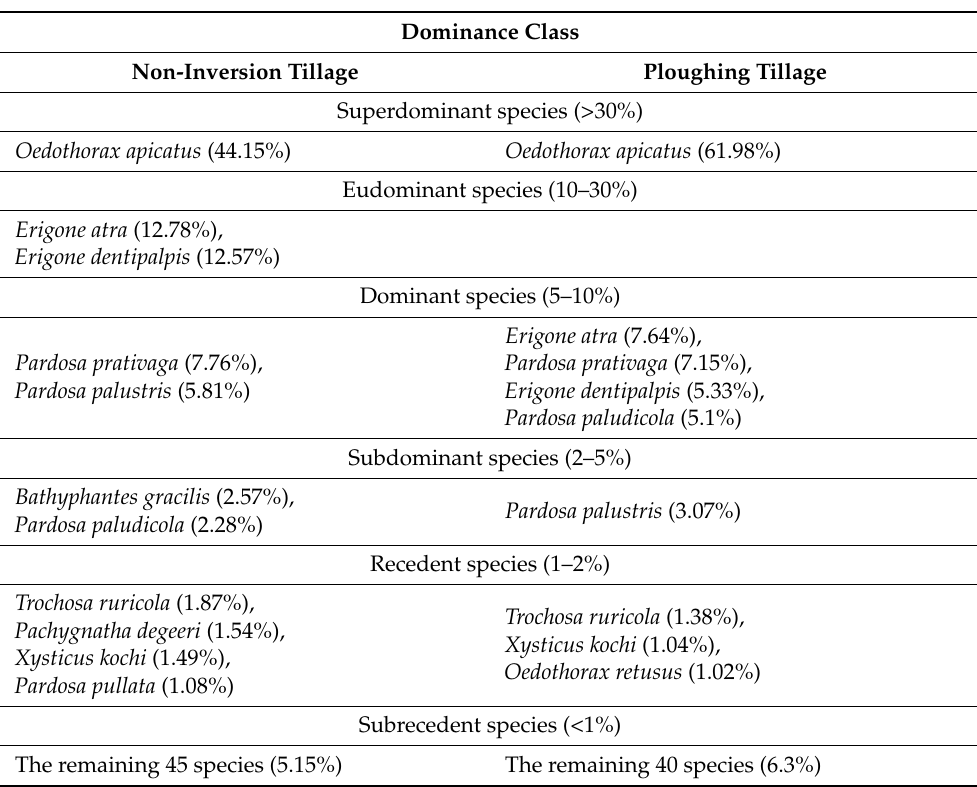
Table 4. The most abundant spider species collected in two tillage systems. The G ó rny and Grüm scale of dominance was used